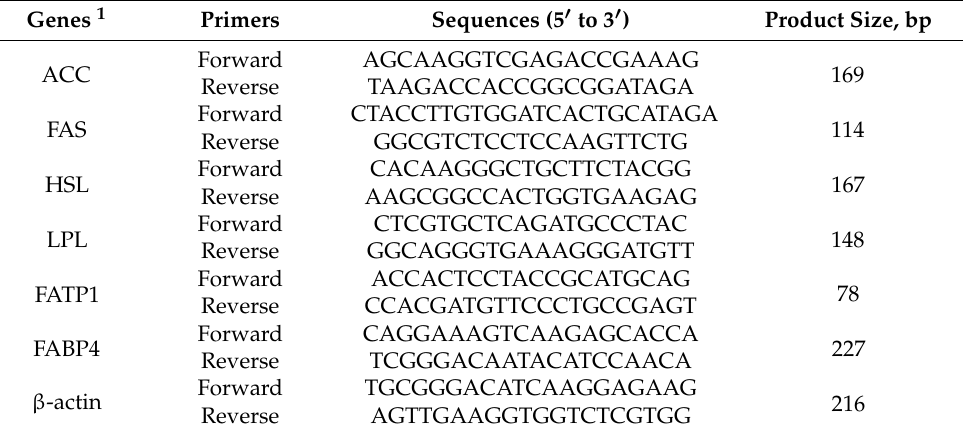
Table 1. Primers used for real-time quantitative PCR. Genes